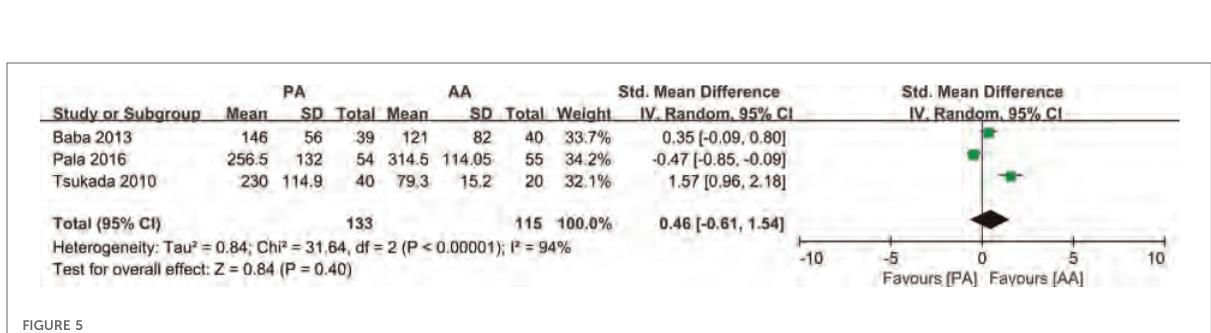
FIGURE 5 Forest plot comparison of surgical blood